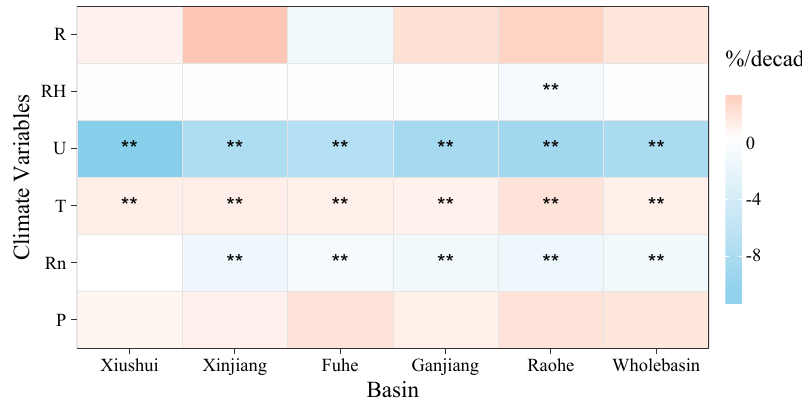
Figure 2. Changes in climatic variables and runoff in the PYLB. R , RH , U , T , R n and P represent runoff, relative humidity, wind speed, temperature, net radiation and precipitation, respectively. The shade of the cell color represents the change rate per decade. The cell labeled with two asterisks (**) denotes the statistically-significant trend at the 1% significance level. The cell without asterisks denotes that the trend is not statistically significant at both the 1% and 5% significance